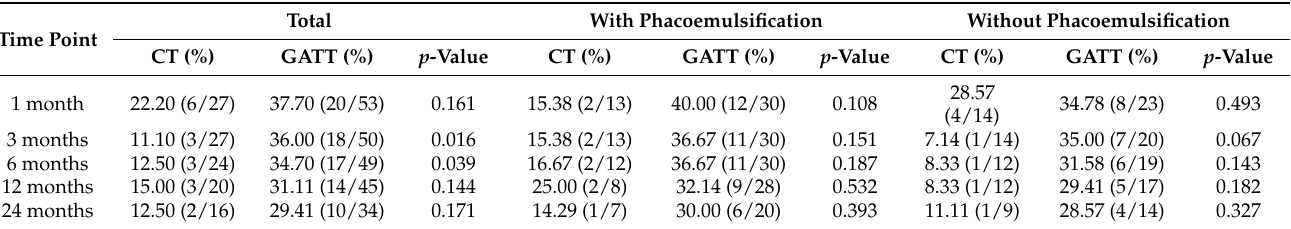
Table 4. Changes in medication-free rates.